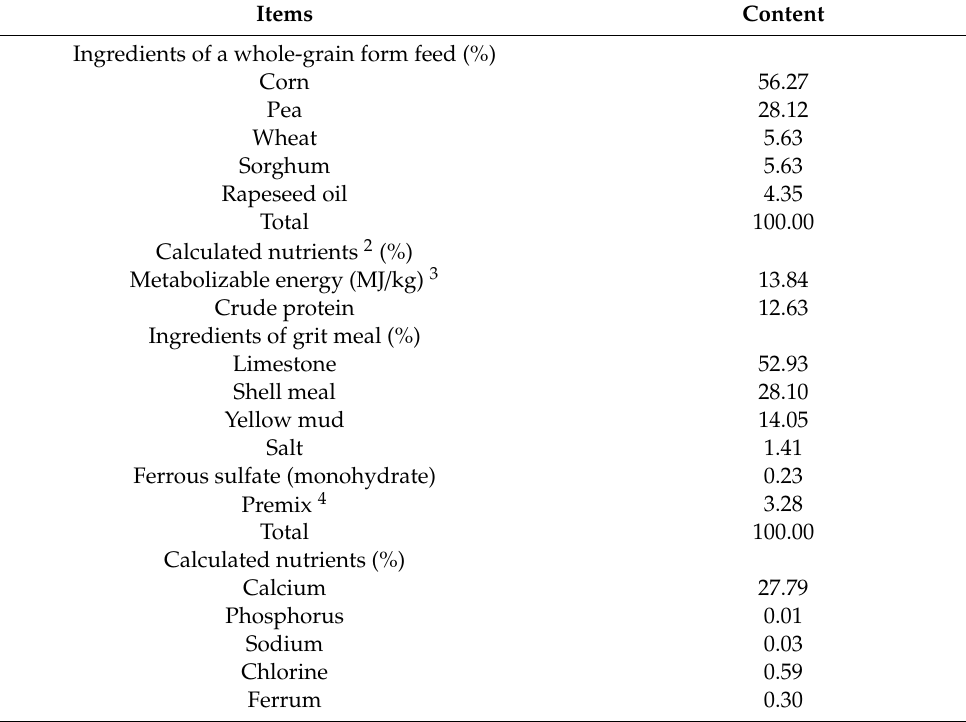
Table 1. Ingredient compositions and nutrient levels of basal diets for parent pigeons 1 (on as-fed basis).